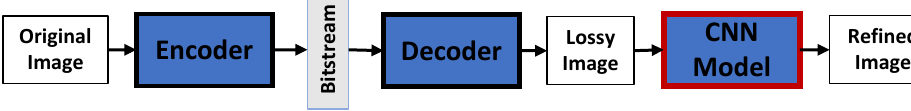
Figure 1. Flowchart of the proposed post-filtering approach.